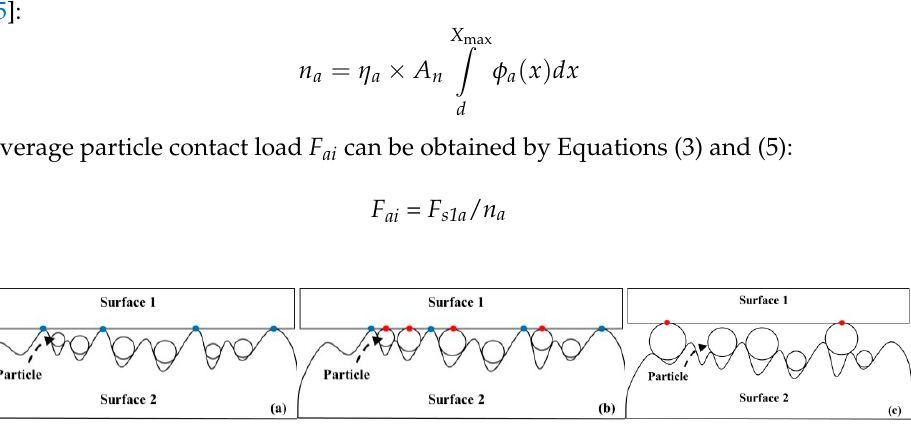
Figure 2. The contact behavior of wear debris between the contact interface ( a ) surface-to-surface two-body contact; ( b ) three-body contact; and ( c ) particle-to-surface two-body contact.